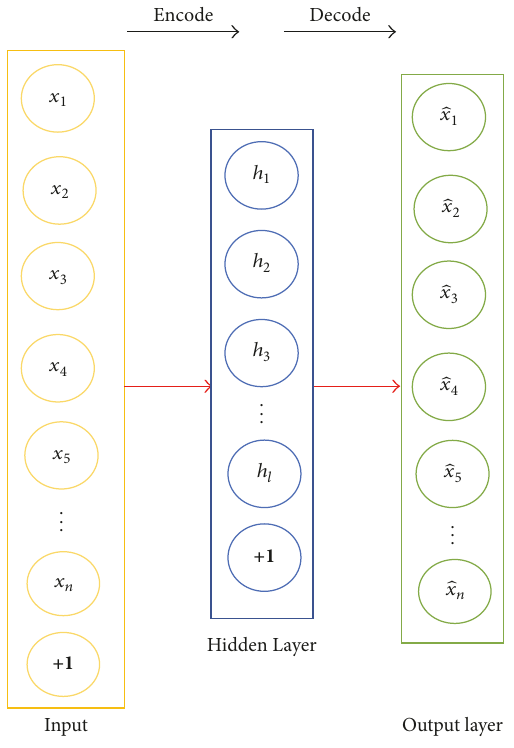
Figure 2: Sketch of a basic